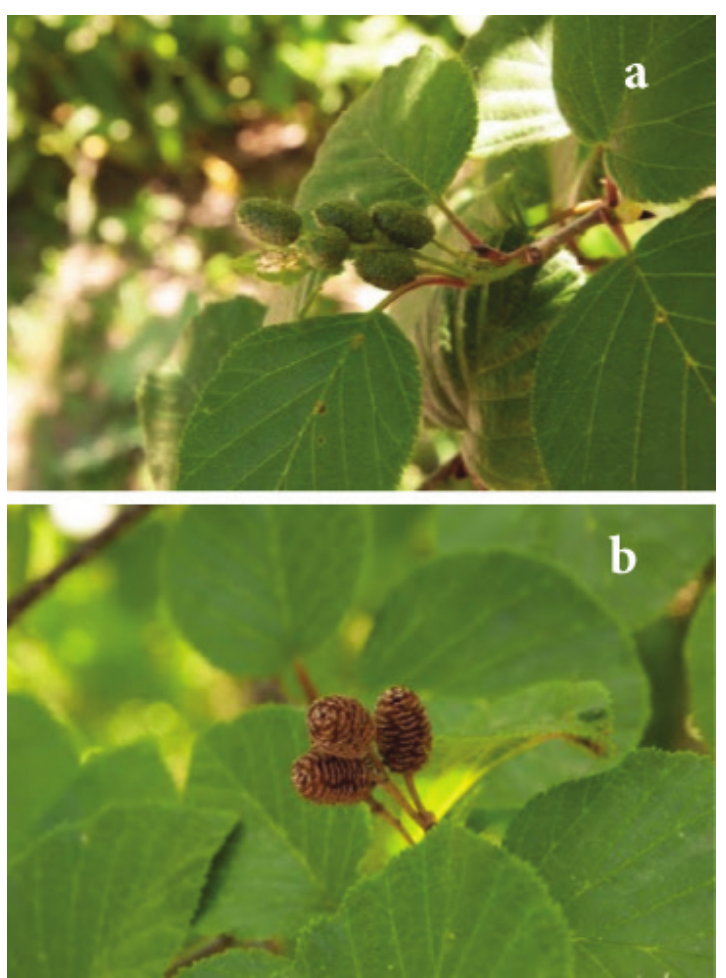
Figure 1. Alnus alnobetula subsp. maximowiczii – images (taken by Jordan Wood) from Arnold Arbore- tum 1462-77*E a ) developing infructescenes; b ) old